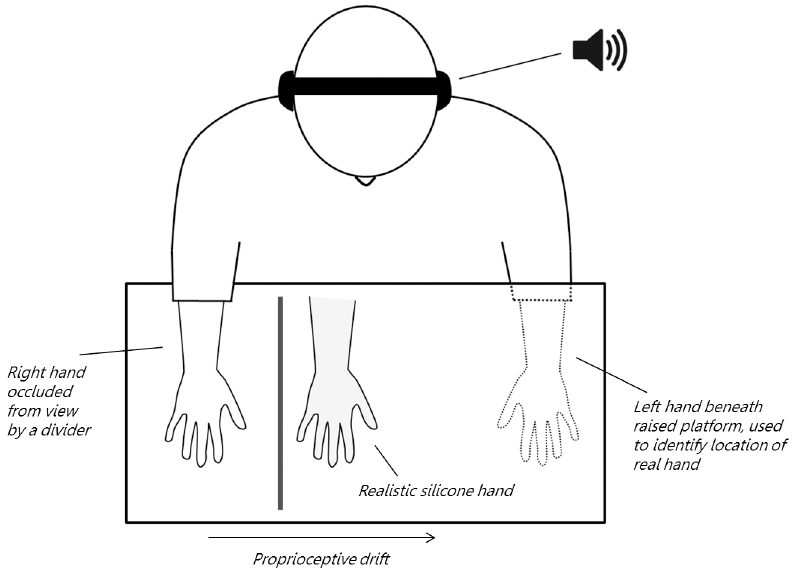
Fig 1. Experimental set-up. The participant is seated at a table on which a raised platform is placed.The participant’s right hand is placedon top of the platform, but occludedfrom view by a divider. The left hand is placedbelow the platform. Duringthe experiment, participants focus their attention on a realistic siliconehand placedin front of them, while their real hand and the fake hand are brushedby the experimenter in either a synchronous or asynchronous fashion. At the end of each trial, participantsuse their left hand to indicate where they think their right index finger is located, by moving their left index finger over a tape measureplaced on the platform on the side of the experimenter. Additionally,they answerednine questionsrelated to their subjectiveexperience duringthe trial.